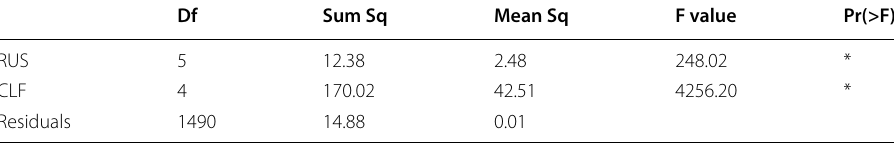
Table 34 ANOVA for RUS and CLF as factors of performance in terms of AUPRC Df Sum Sq